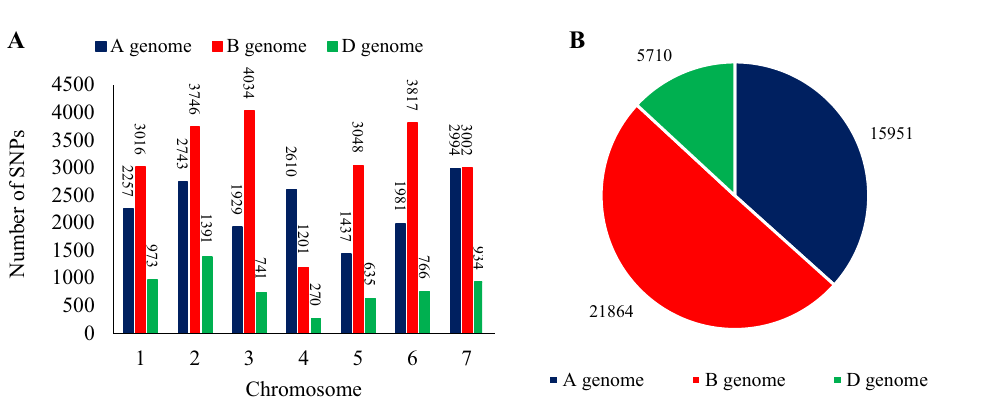
Figure 2. Correlation coefficients between morphometric seed traits for Iranian wheat landraces and cultivars in the well-watered ( A ) and rain-fed ( B ) environments.